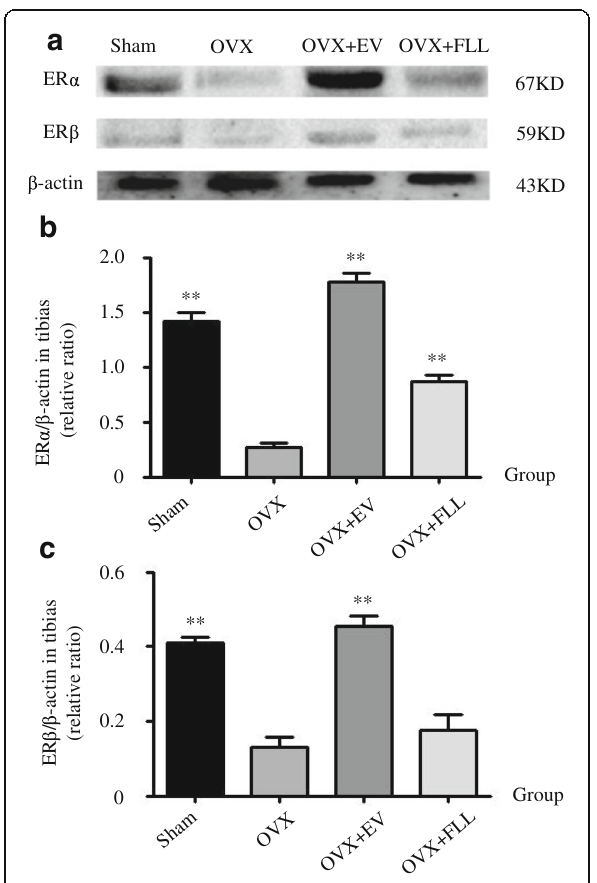
Fig. 3 The representative images ( a ) and images analysis results of western blot ( b and c ) showing the effects of FLL on the expressions of ER α and ER β in the tibias of the rats. β -actin was taken as the internal control. Data are presented as mean ± SD. ** P < 0.01 compared with the OVX control group